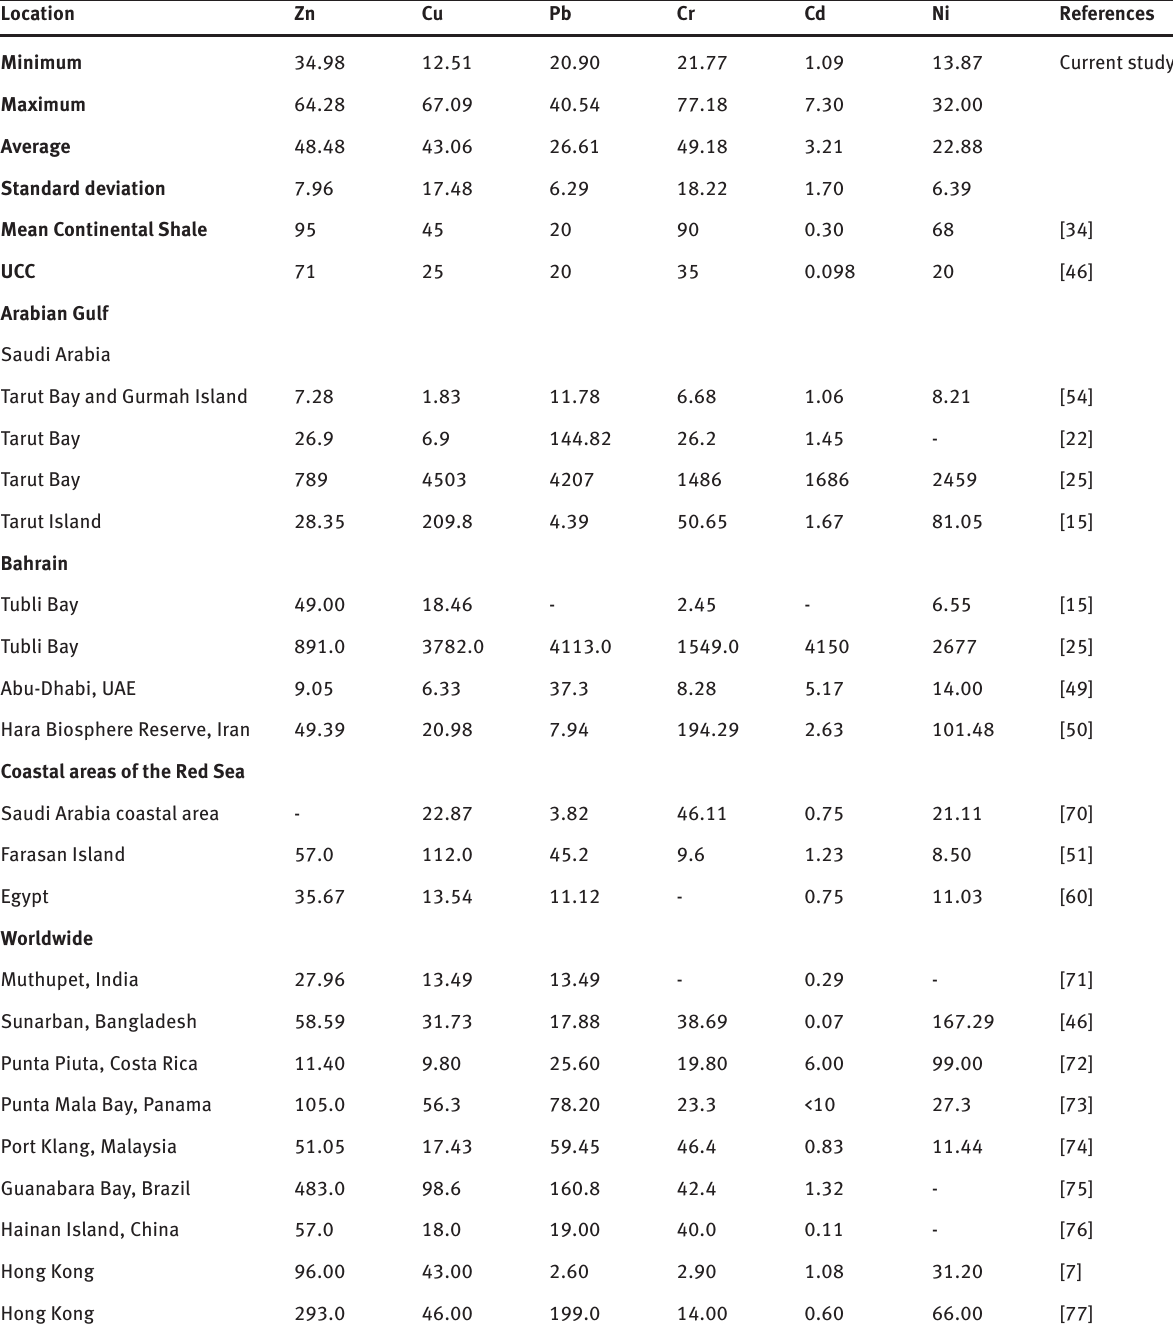
Table 3: Comparison of trace elements concentrations (μg g -1 ) in marine sediments with regional and worldwide studies.